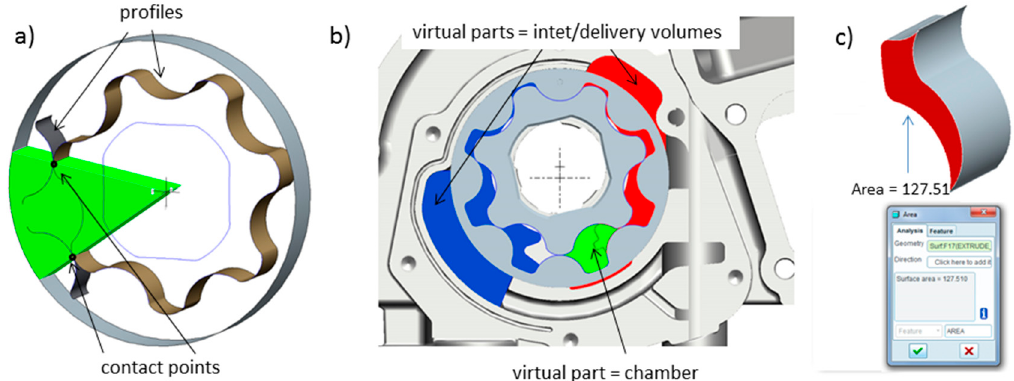
Figure 20. Some steps of a CAD procedure applied to a gerotor pump: ( a ) generation of the chamber part; ( b ) creation of the inlet/outlet volumes; ( c ) measuring feature for evaluation of the frontal area.